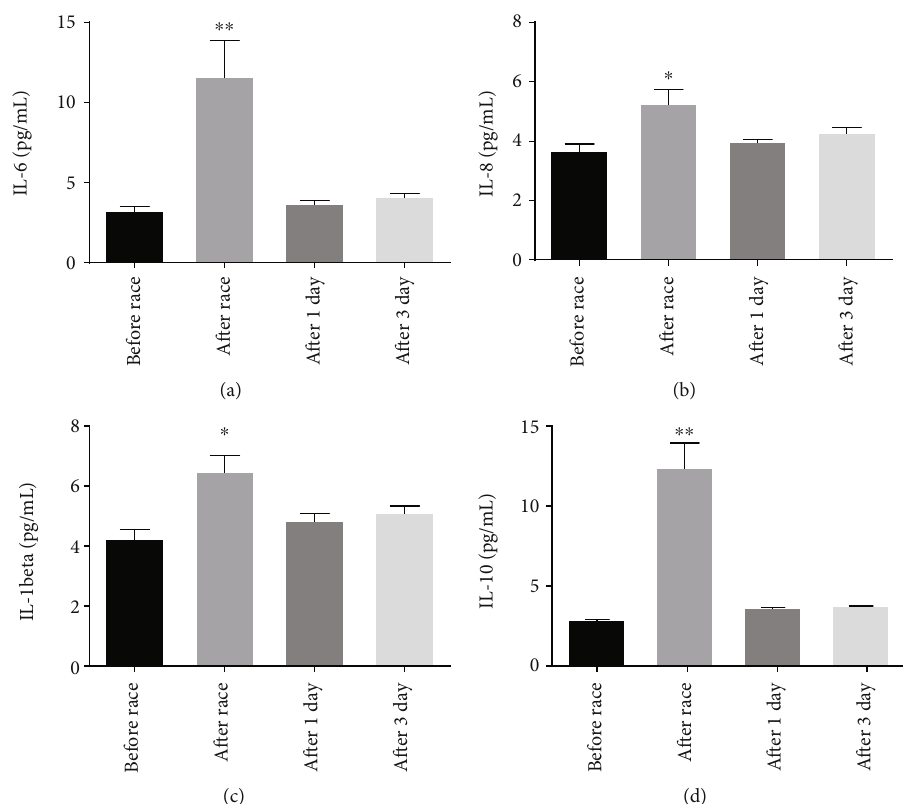
Figure 1: E ff ect of marathon on cytokines. The in fl ammatory mediators evaluated were interleukin- (IL-) 6, IL-8, IL-1 β , and IL-10 before, immediately after, 1 and 3 days after the race. The values are shown as mean ± SEM of 44 runners. ∗ p < 0 : 01 vs. before race. ∗∗ p < 0 : 0001 vs. before race. Table 1: Daily energy intake, macronutrient, cholesterol, and fi ber